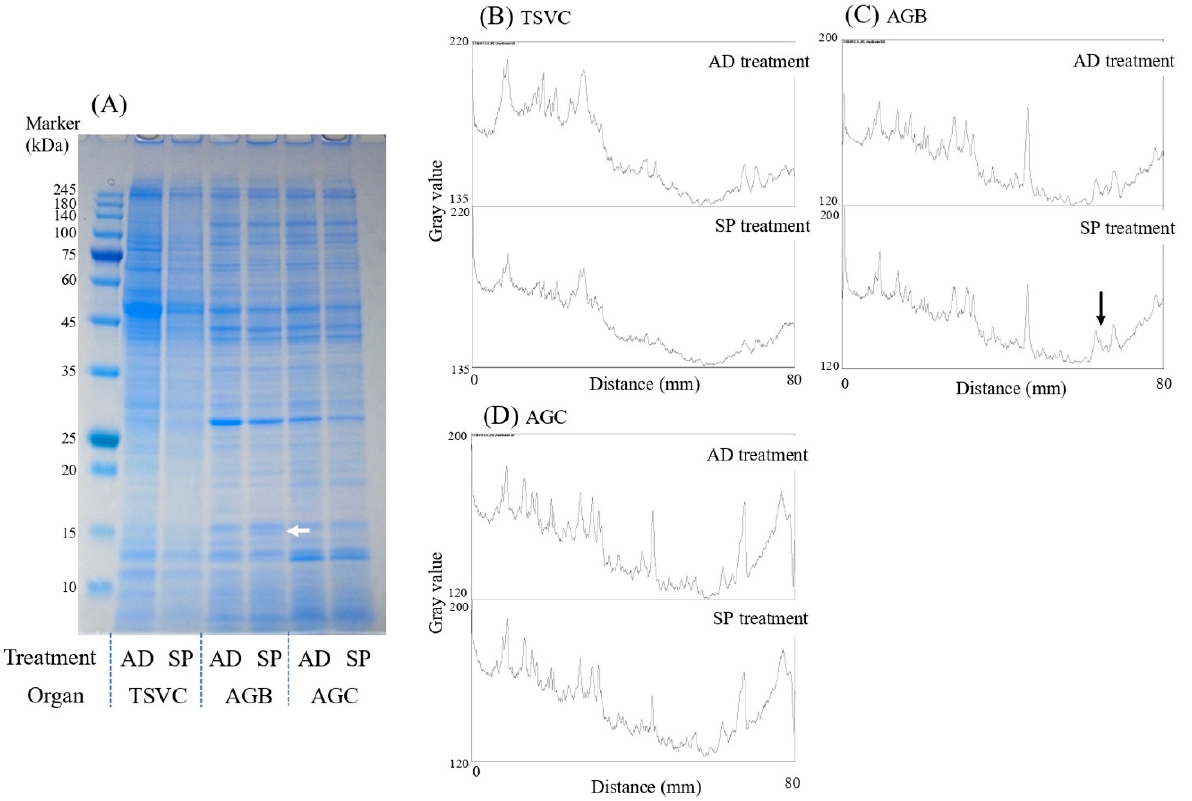
Figure 5. ( A ) a representative gel image of the male testes-seminal vesicles complex (TSVC) and accessory gland B (AGB) and C (AGC) from the artificial diet (AD) and sweet potato (SP) treatments of E. postfasciatus. The white arrow shows a male SP treatment-specific protein of about 15 kDa in size. Comparisons of gray values between AD and SP treatments in testes-seminal vesicles complex ( B ), AGB ( C ), AGC ( D ). The black arrow in ( C ) shows a SP treatment-specific protein of about 15 kDa in